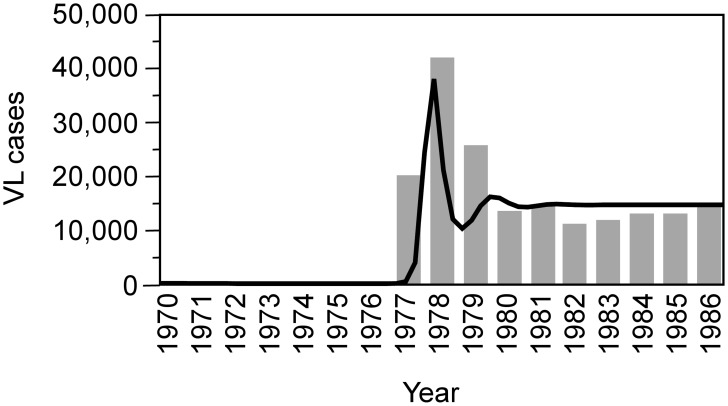
Observed and simulated re-emergence of infection dynamics after local extinction.Observed number of VL cases (grey bars) reported in India from 1970–1986 (source: Ministry of Health and Family Welfare, Government of India), together with the predicted number of cases (black curve) derived from a previously developed mathematical model [26]. As a side effect of malaria vector control, VL incidence dropped to very low levels until 1976 which has been mimicked in this simulation by reducing the sand fly population by 85% between 1967 and 1976. The residual infection predicted by the model for 1976 has been used in this simulation as seed for the observed re-introduction of VL in 1977 when the density of sand flies was assumed to return to pre-control levels because of cessation of malaria vector control measures.